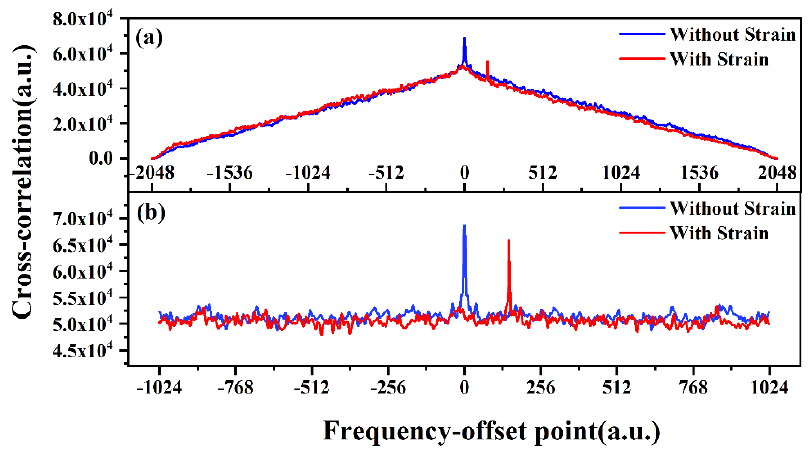
Figure 6. The dependence of the wavelength shift on strain at a single measuring point. ( a ) Cross-correlation in time domain; ( b ) cross-correlation in frequency domain.